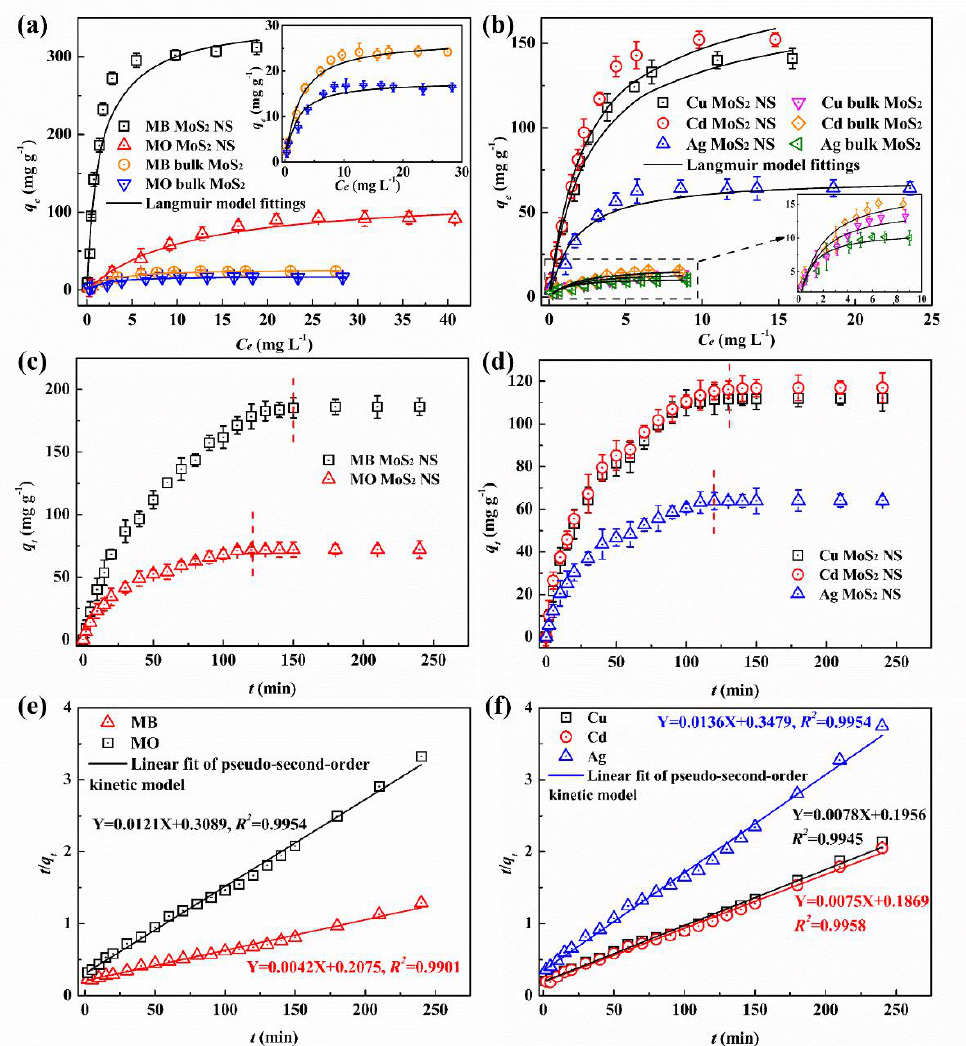
Figure 6. Adsorption isotherms ( a ) and kinetics ( c , e ) of MB, MO for bulk MoS 2 and MoS 2 NS at 20 mg L − 1 ; adsorption isotherms ( b ) and kinetics ( d , f ) of Cu 2 + , Cd 2 + and Ag + for bulk MoS 2 and MoS 2 NS at 15 mg L − 1.